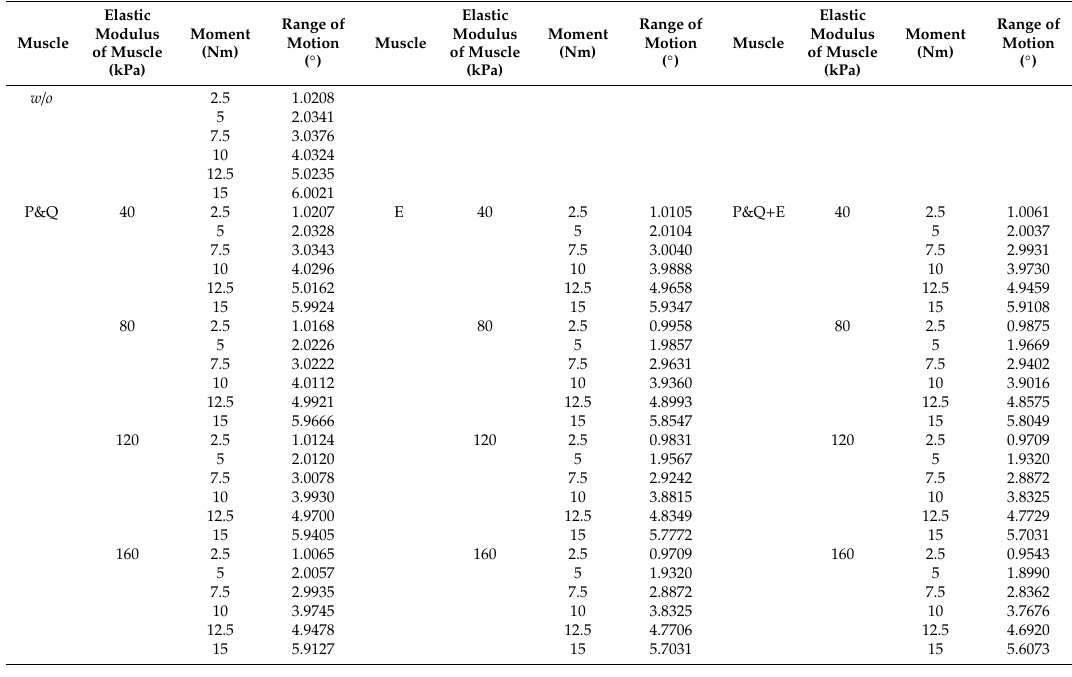
Table 3. Range of motion of various models under pure moments.